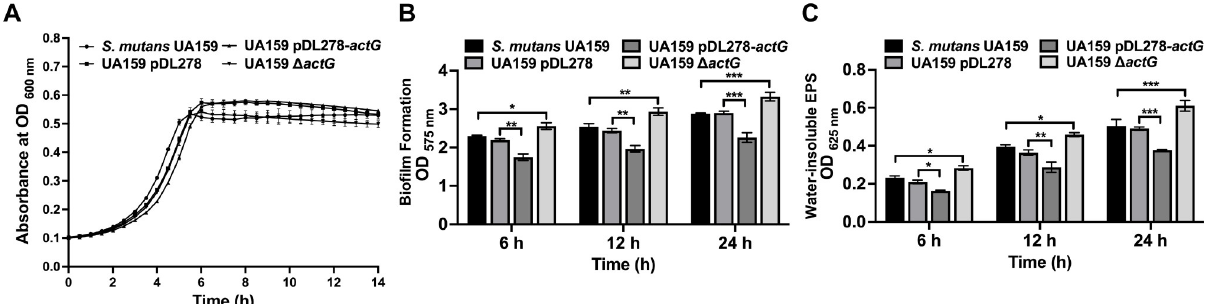
Fig 1. Effect of actG on bacterial growth, biofilm formation, and water-insoluble EPS synthesis in S . mutans . (A) Growth curves of S . mutans UA159, UA159 pDL278, UA159 pDL278 -actG , and UA159 Δ actG in anaerobic condition for 12 h. (B, C) The biofilm biomass was determined by crystal violet staining assay (B) and anthrone-sulfuric acid method (C) when cultured in BHIS (1% sucrose wt/vol) in anaerobic condition for 6h, 12h, and 24h, respectively. Results are presented as mean ± SD ( � P < 0.05, �� P < 0.01 or ��� P < 0.001).